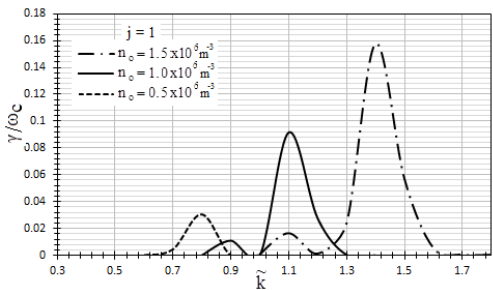
Fig.8: Variation of Growth Rate with respect to various values of No at other plasma parameters being B o = 80nT, θ =30 o , K B T || =400eV and